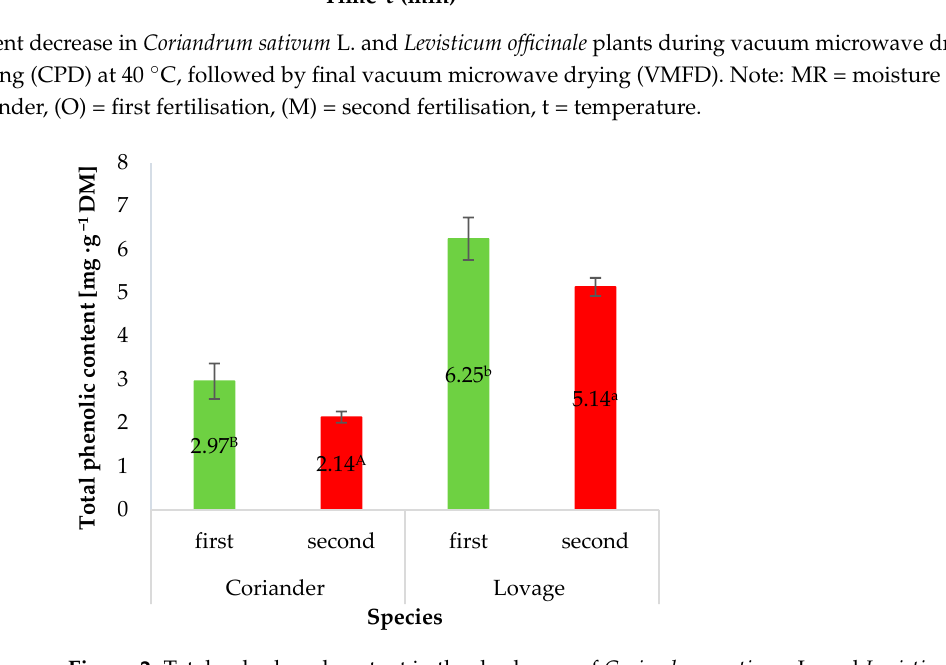
Figure 2. Total polyphenol content in the dry leaves of Coriandrum sativum L. and Levisticum officinale in relation to the fertilizer used. Differences in the results of polyphenol content are indicated by different letters.